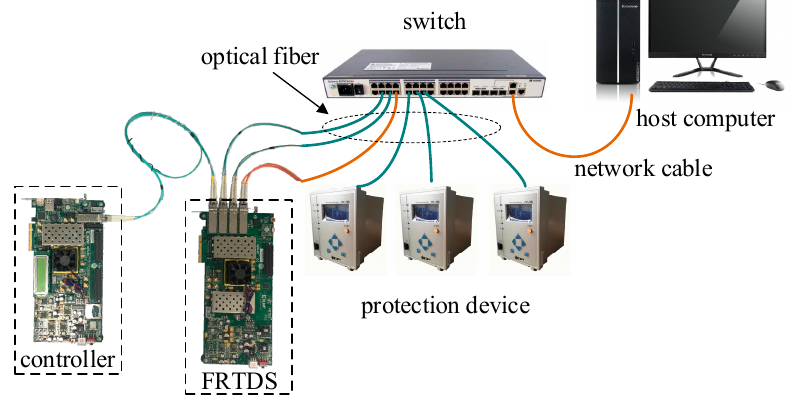
Figure 6. The structure of hardware in the loop simulation system based on FRTDS.